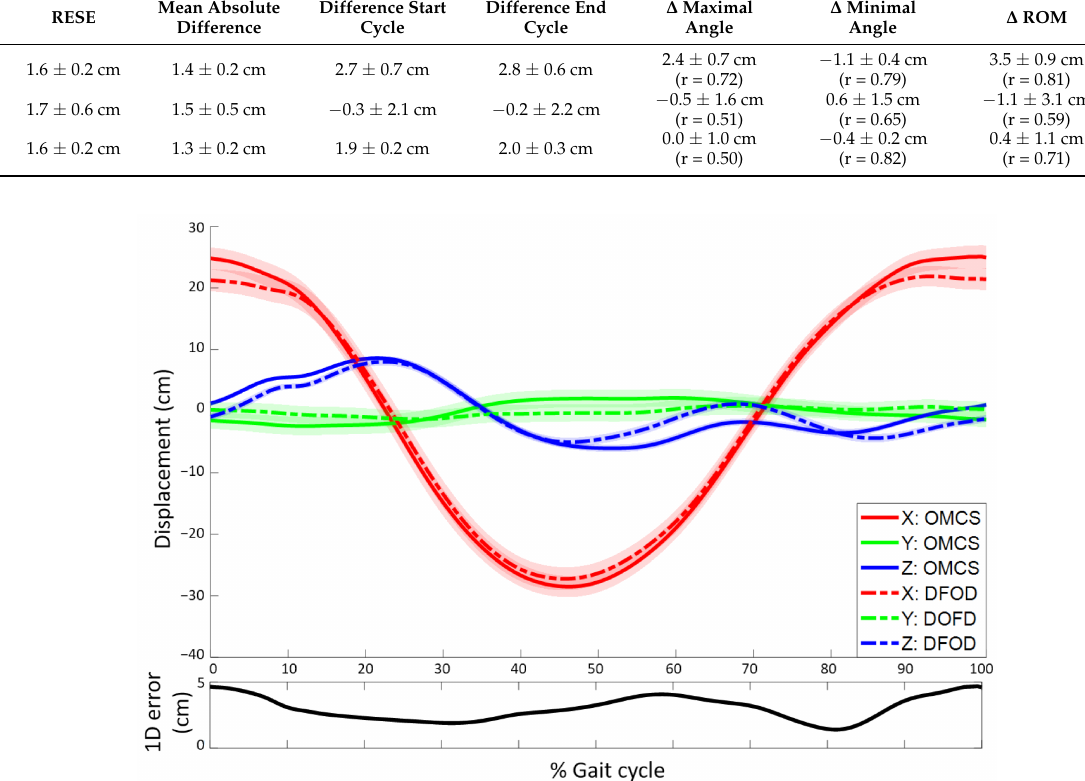
Figure 6. ( Top figure): Mean time-normalized displacement of a sensor (DFOD, dashed line) and cluster marker (OMCS, solid line) on the lower leg (in Ψ f ) as a function of the gait cycle. Shaded areas represent the standard deviation around the mean. ( Bottom figure): 1D displacement error as a function of the gait cycle. Data are shown for a representative subject during one minute of running. Positive displacements in the X, Y, and Z-axis represent movement into the forward, sideward (left), and upward direction, respectively. The origin moves forward with the cycle average